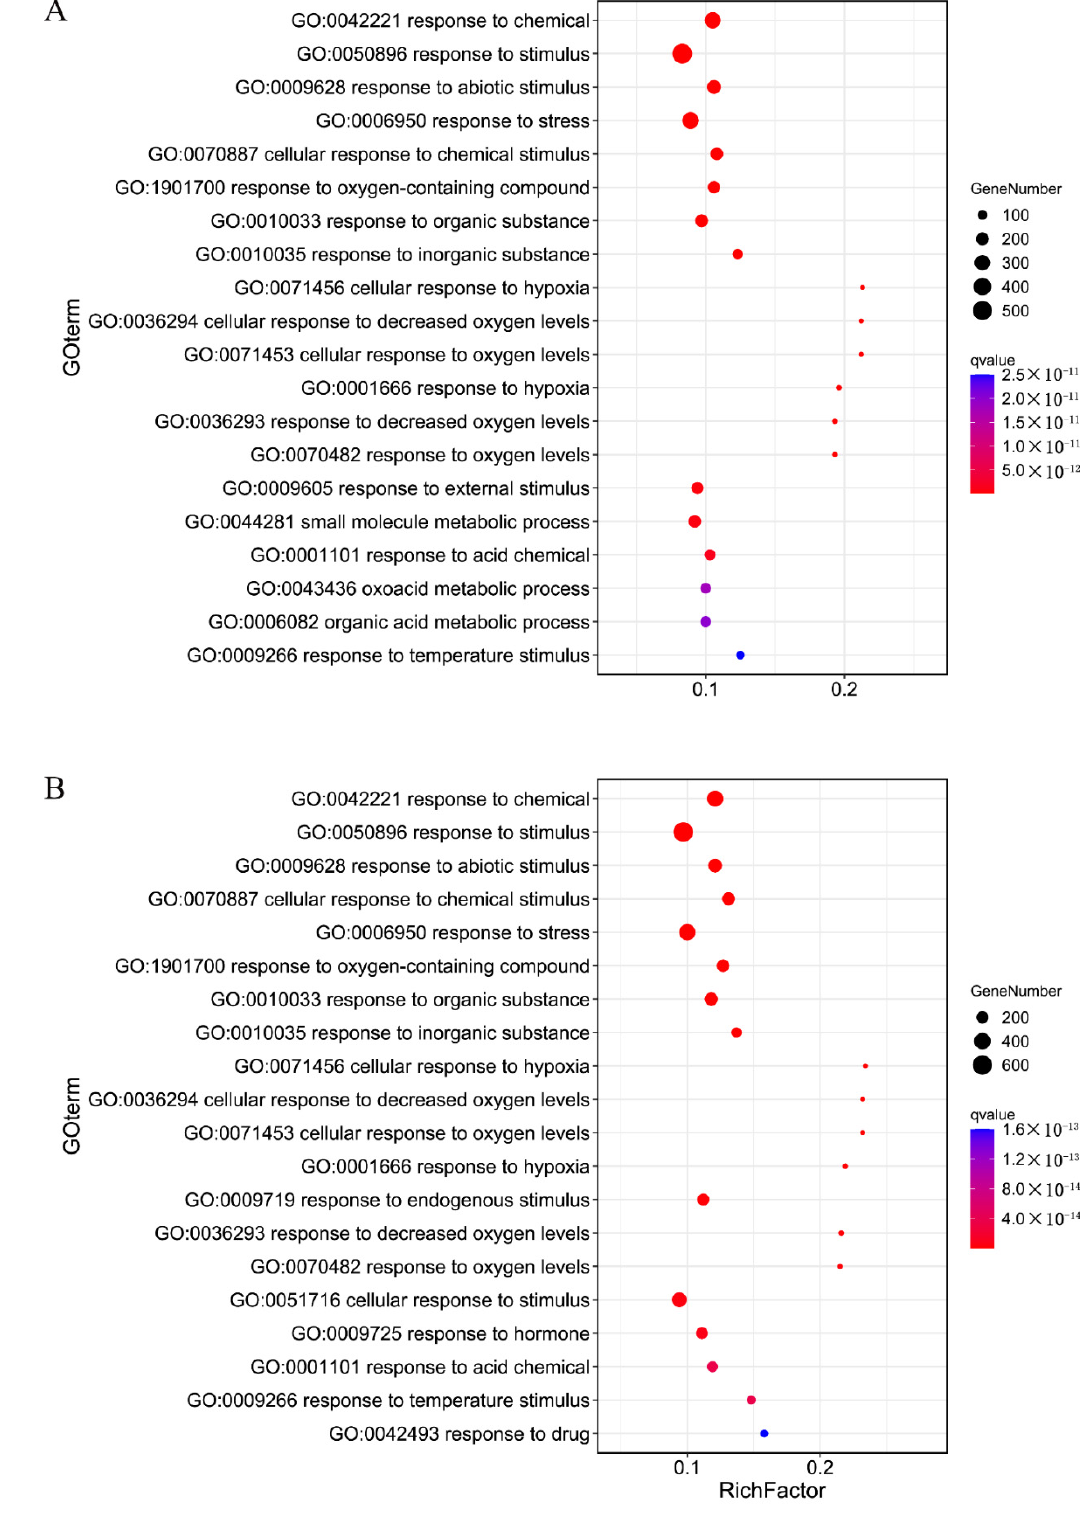
Figure 3. Top 20 enriched GO terms of M. cerifera after two treatments (A, LAS; B, HAS). Rich factor indicates the degree of enrichment, that is, the p value after multiple hypothesis testing and ranges between 0 and 1. The closer the p value is to zero, the more significant the enrichment.